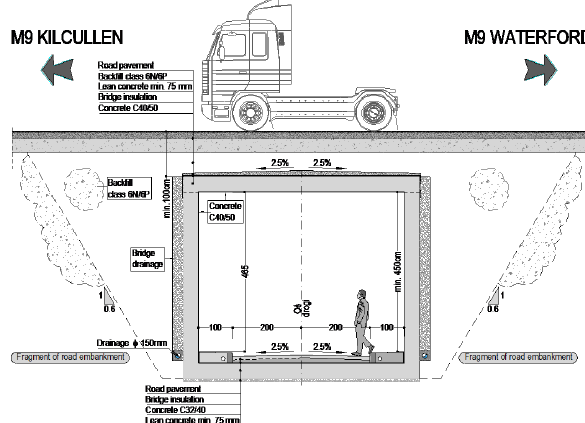
Figure 2: Cross section of